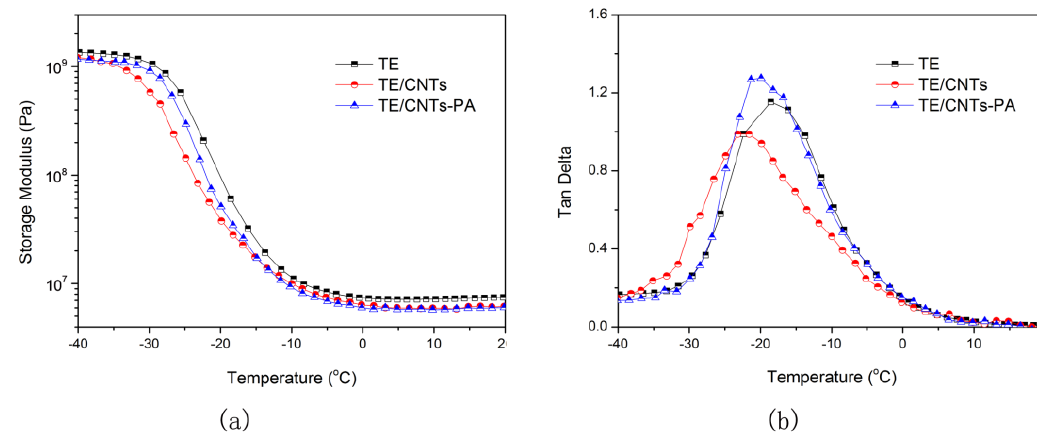
Figure 8 . Dynamic storage modulus ( a ) and tan δ ( b ) of TE and TE/CNTs ‐ PA nanocomposites. Figure 8. Dynamic storage modulus ( a ) and tan δ ( b ) of TE and TE/CNTs-PA